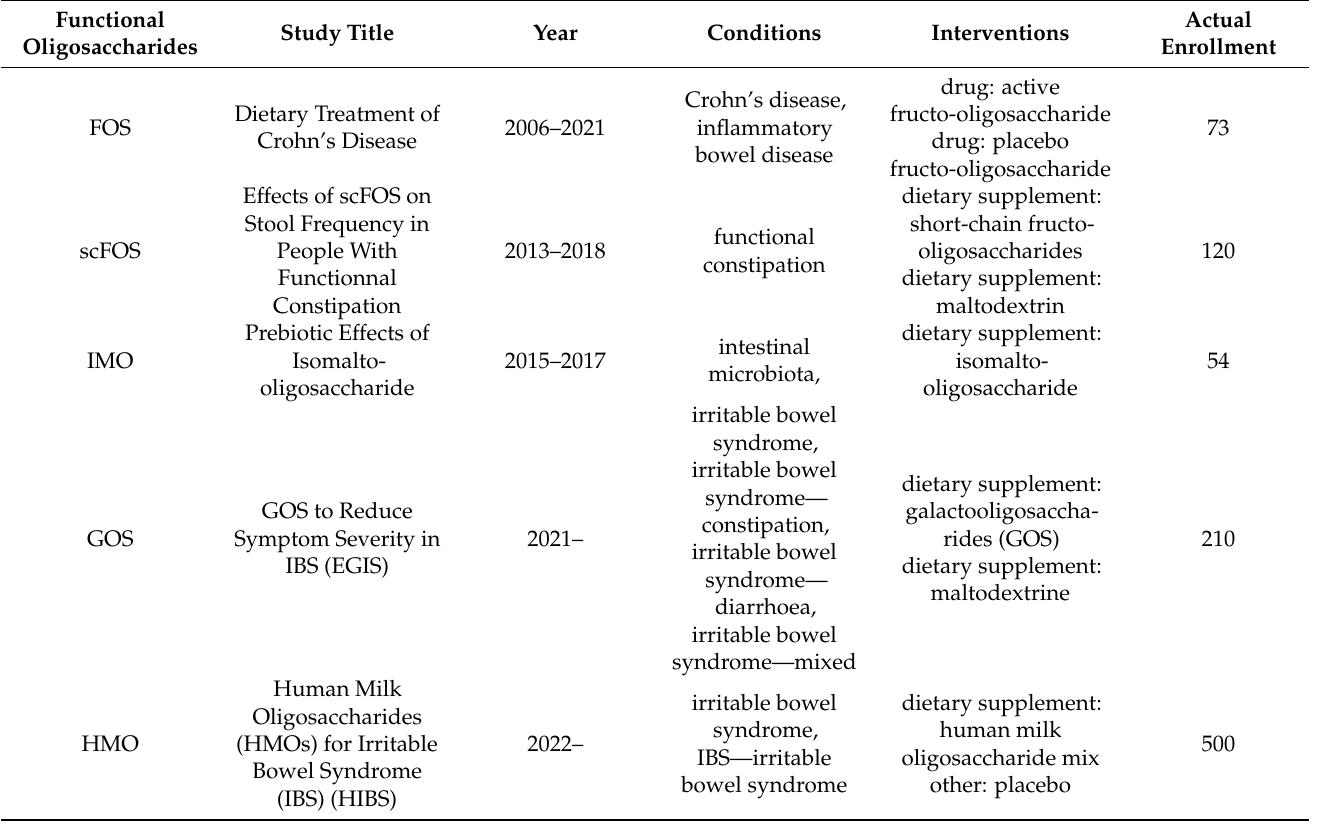
Table 1. Clinical study of common functional oligosaccharides in intestine-related